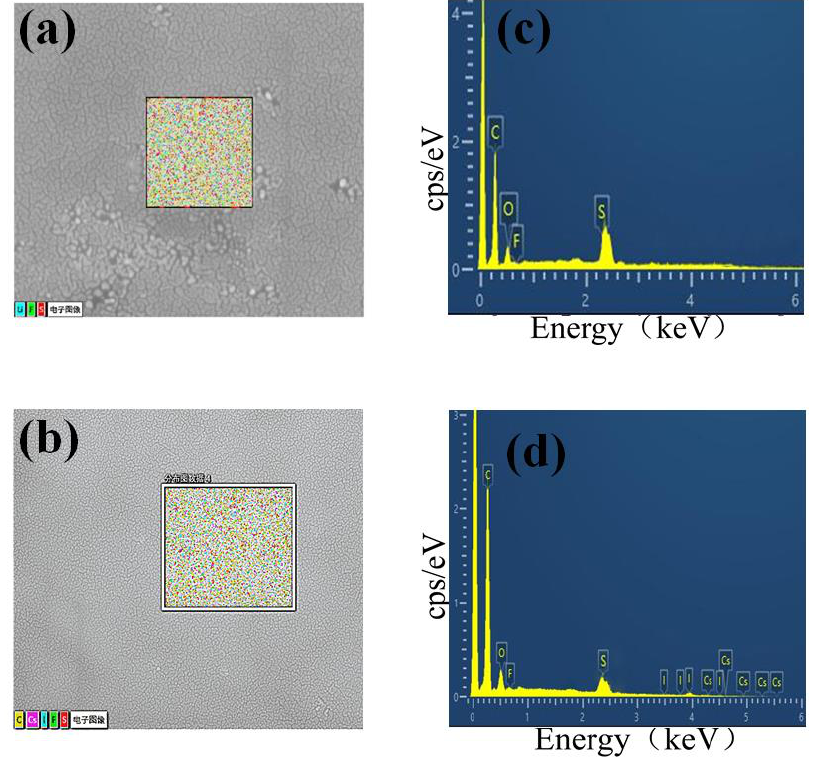
Figure 3. Energy dispersive X-ray energy spectrum of HTL 0.0 wt% ( a , c ) and HTL 0.4 wt% ( b , d ), respectively.